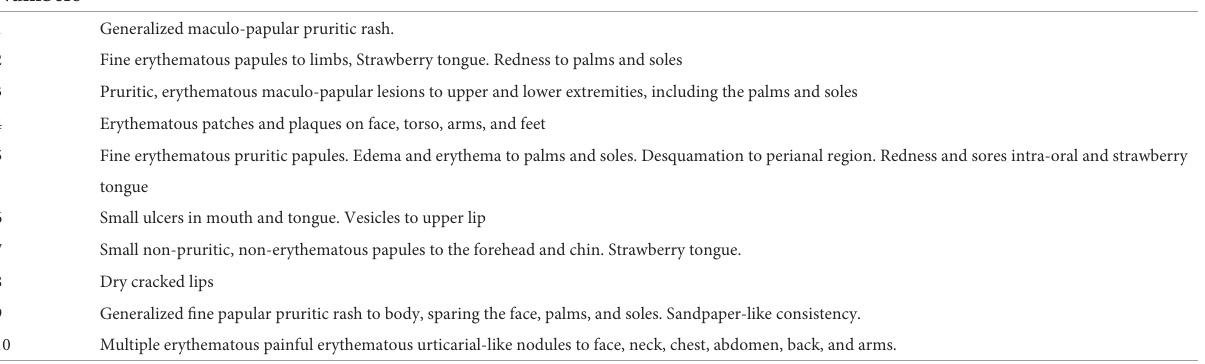
TABLE 2B Description of mucocutaneous manifestations in the hospitalized children and adolescents with MIS-C.